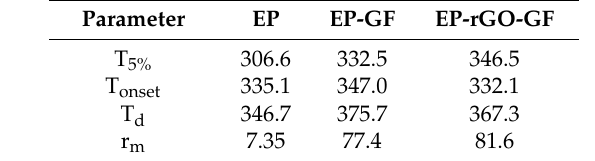
Table 4. Results of TGA analysis on neat epoxy and of the relative composites.